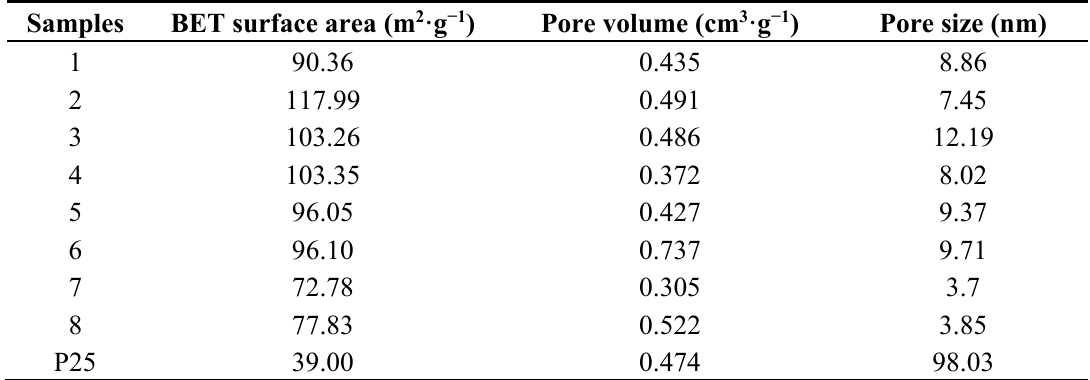
Table 3. BET (Brunauer, Emmett, Teller) surface area, pore volume and size for samples 1–8 and